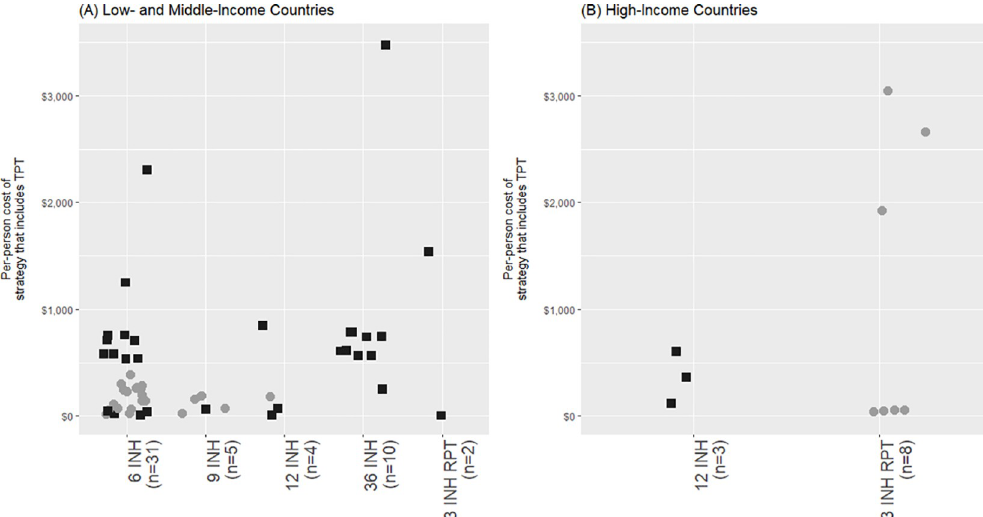
Fig 3. Per-person cost of TPT versus no TPT, by TPT regimen and country-level income. ART, antiretroviral therapy; INH, isoniazid; RIF, rifampin; RPT, rifapentine; TB, tuberculosis; TPT, tuberculosis preventive therapy. Each data point represents a study arm or “strategy.” Outliers are analyzed in further detail in the Outliers section of S1 Text. Costs displayed in this figure include program costs related to TPT delivery (drug costs, personnel costs, and material costs) as well as costs related to TB care for those who develop active TB (drug costs, hospitalization costs, and personnel costs). Importantly, these come from studies that compared the use of TPT to no TPT and do not include studies that comparing directed TPT to TPT for all. The use of ART is distinguished in this figure; filled black squares ( ■ ) represent strategies that included the cost of ART, while filled gray circles ( ● ) represent strategies that did not include the cost of ART.